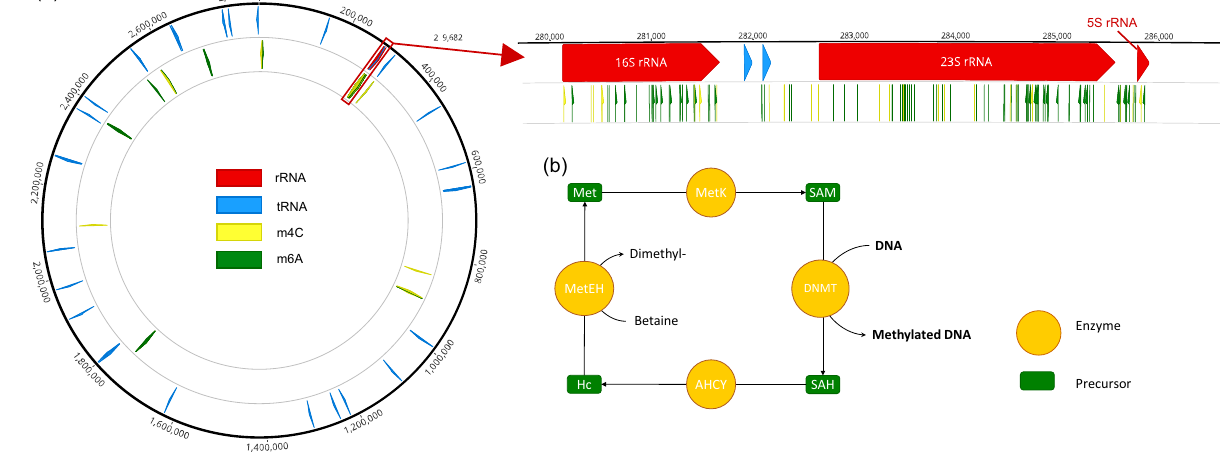
Figure 5. ( a ) The methyl modification regions in B. thermophilus EPR9N genome. Zoomed portion shows m4C and m6A base modifications in the rRNA region. ( b ) Enzymatic pathway involved in DNA methylation process. DNMT DNA methyltransferase, AHCY S-adenosyl-homocysteine hydrolase, Met Methionine, Hc Homocysteine, SAH S-adenosyl-homocysteine, SAM S-adenosyl